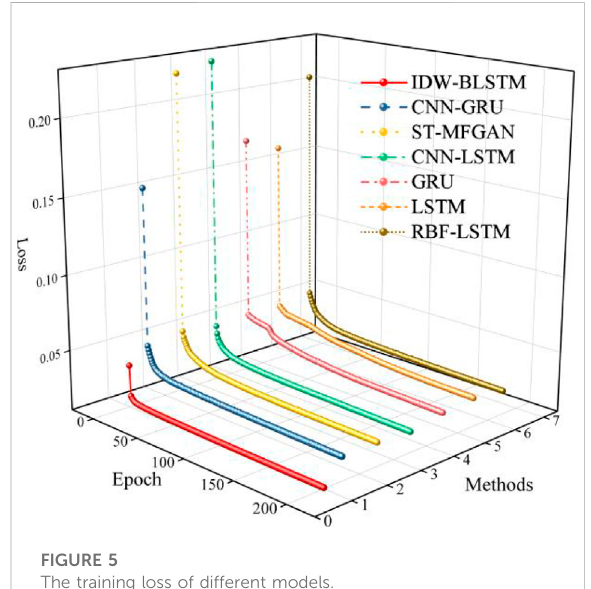
FIGURE 5 The training loss of different models.